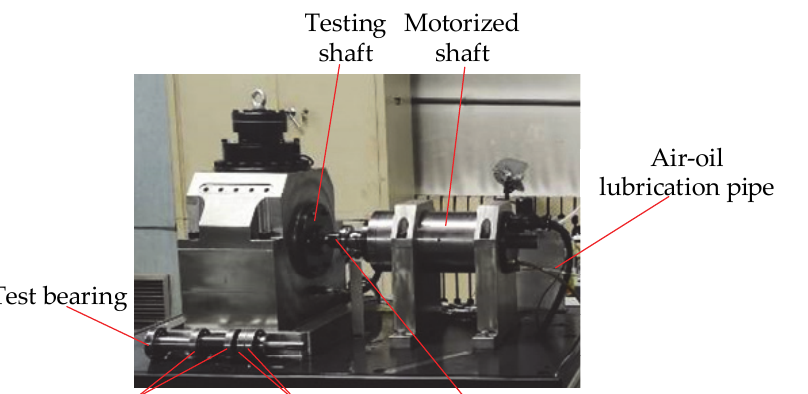
Figure 7. Experimental equipment. Table 1. Test plan.